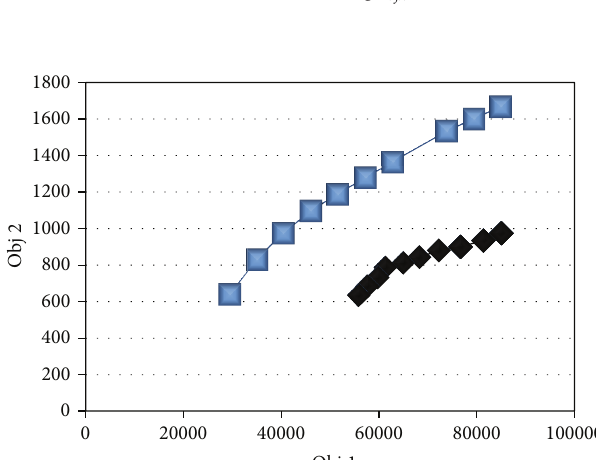
Figure 6: Reducing 𝛿 𝑖𝑗𝑘 .